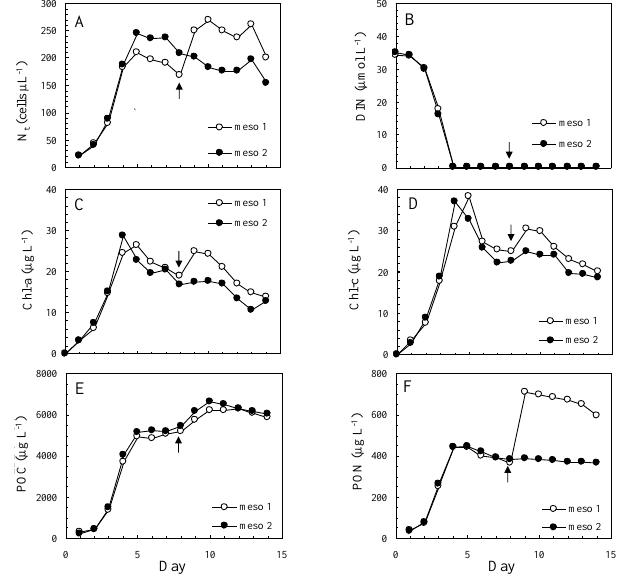
Figure 2. (a–f) Phaeocystis , nutrient and carbon dynamics in two mesocosms (meso 1, meso 2) in time. (a) Cell abundances (cellsµL − 1 ) , (b) dissolved inorganic nitrogen (DIN,µmol L − 1 ) , (c) chlorophyll a (Chl a , µgL − 1 ) , (d) chlorophyll c (Chl c ,µgL − 1 ) , (e) particulate organic carbon (POC,µgL − 1 ) , (f) particulate organic ni- trogen (PON,µgL − 1 ) . The arrow indicates the nutrient addition to mesocosm 1 after sampling on day 8.